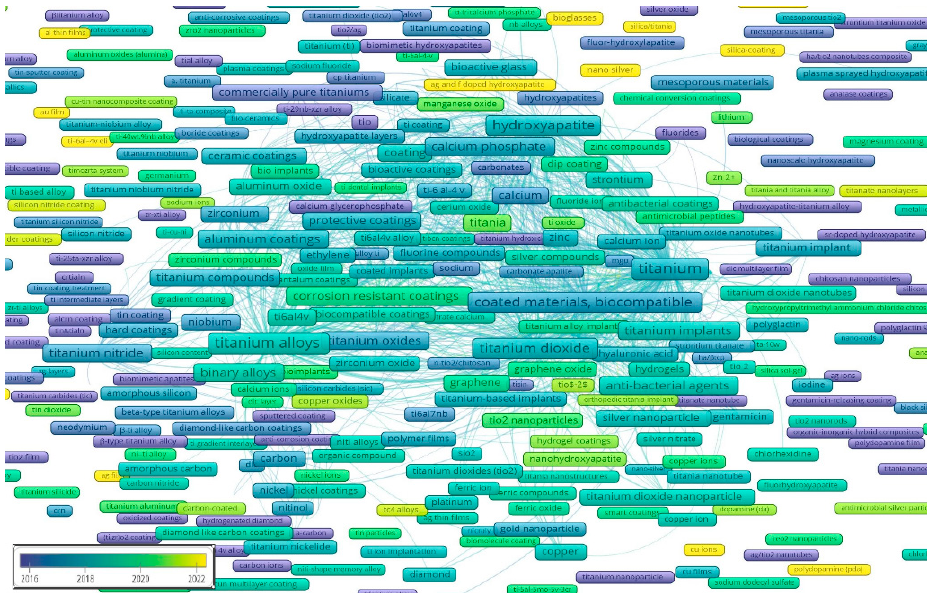
Figure 4. Word cloud based on keywords of publications for the keywords (titan* AND implant*) and (coating* OR (surface AND modi fi cat*)) from 2018 to the present (according Scopus).